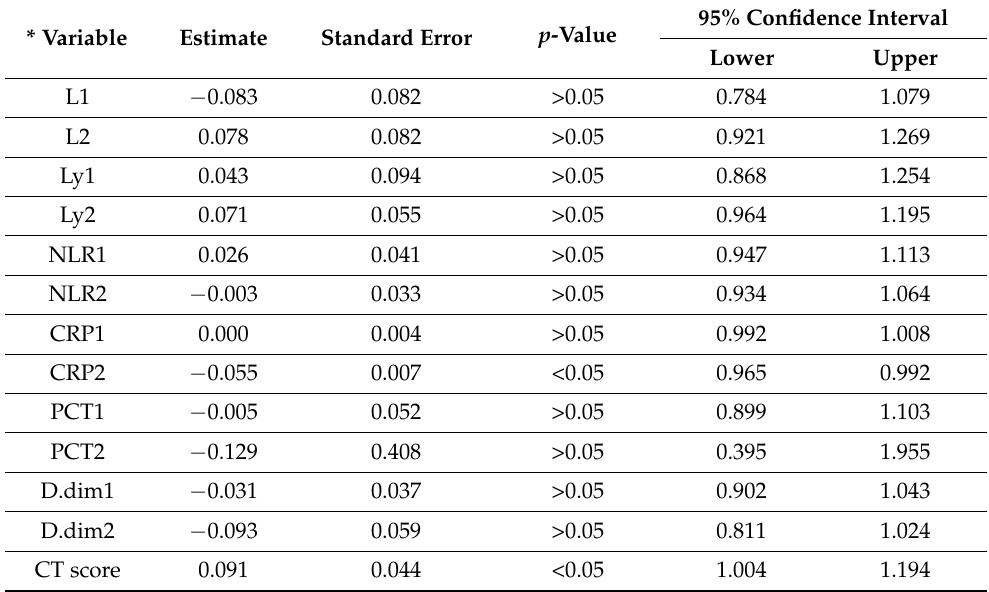
Table 5. Biochemical and clinical variables as predictors of disease outcome (0—death,